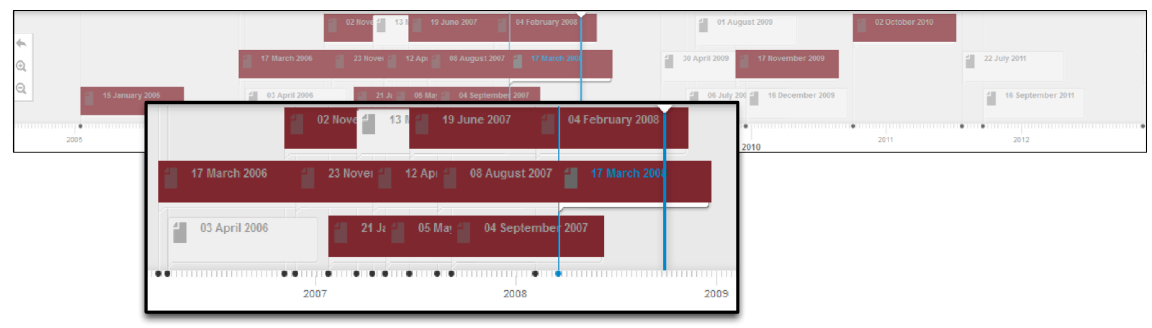
Figure 7. Profile